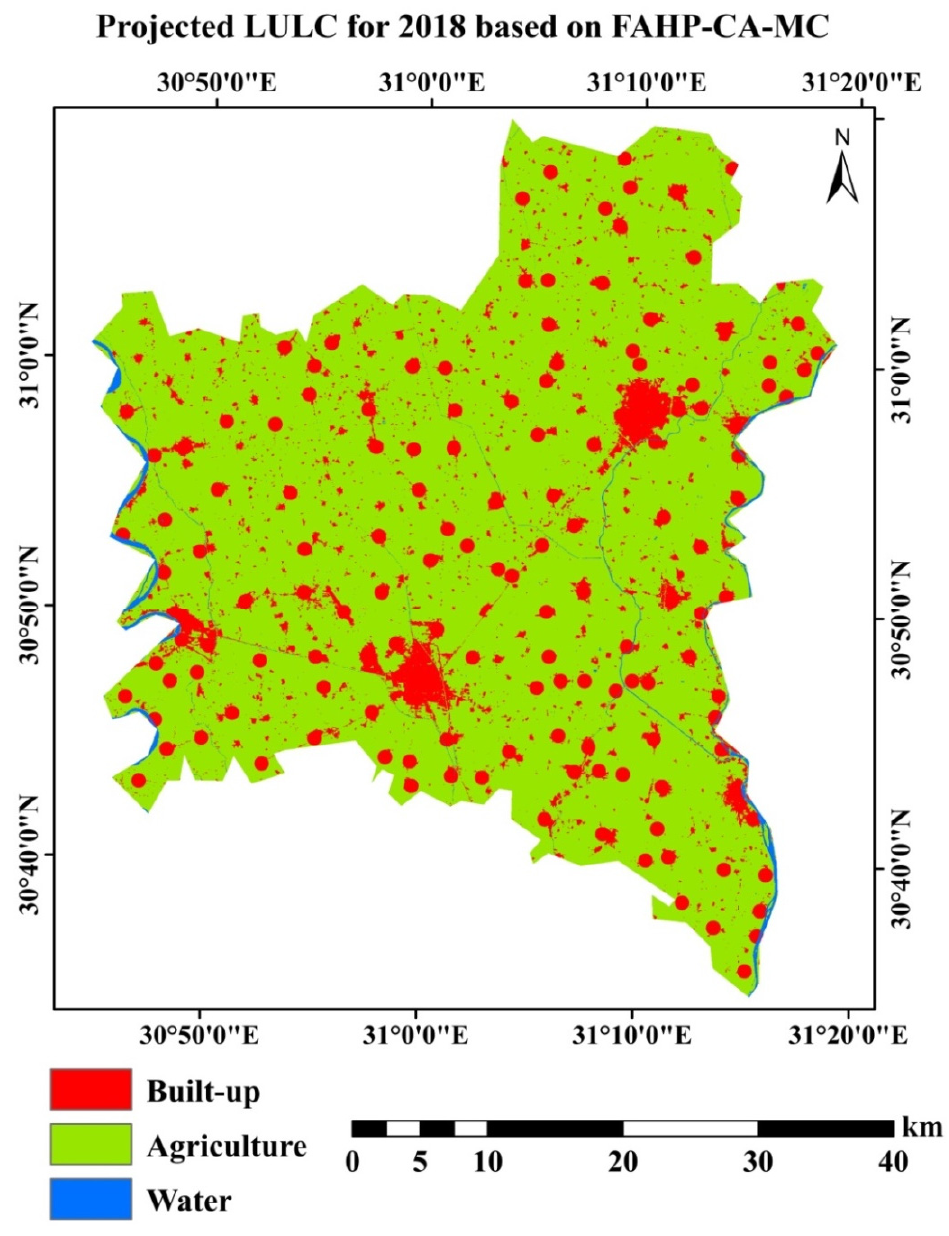
Figure 5. Simulated LULC map for 2018 based on the hybrid model of FAHP-CA-Markov chain.